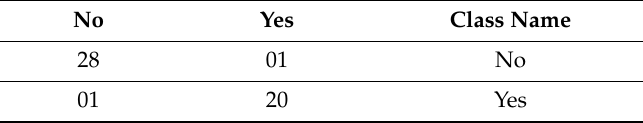
Table 22. Matrix with reduced dimensions for fold 2.